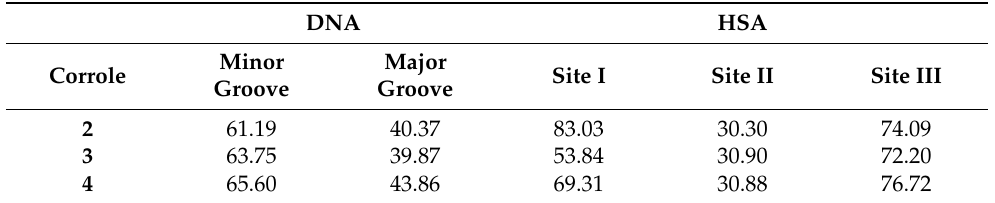
Table 7. Molecular docking score values (dimensionless) for the interaction between DNA/HSA and each corrole derivative under study into the corresponding main binding site. DNA HSA Minor Major Corrole Site I Site Groove Groove